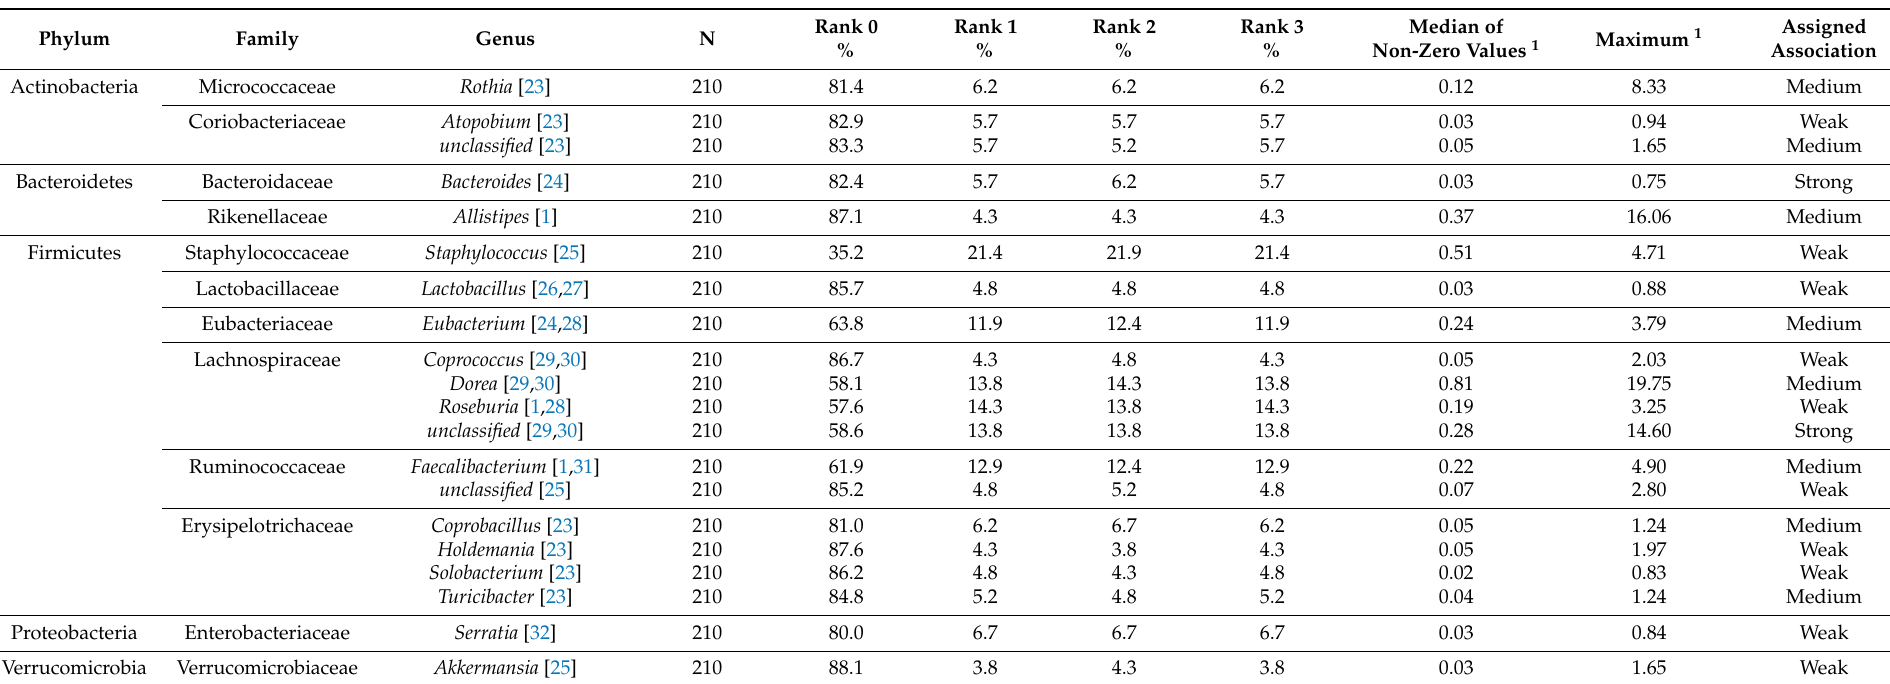
Table 1. Description of the 20 operational taxonomic units (OTUs) that were assigned an association with the simulated binary (test) variable. In the weighted quantile sum regression, relative abundance of each OTU within the gut microbiome from each participant was ranked as 0 if relative abundance was 0, and then by tertiles above 0 for ranks 1–3. Table columns represent the taxonomy, sample size, row percent of observations at each rank level, median and maximum of non-zero relative abundance, and level of assigned association with the test variable ( β = 8, 4, 2 for strong, medium, and weak, respectively) for the 20 OTUs assigned an